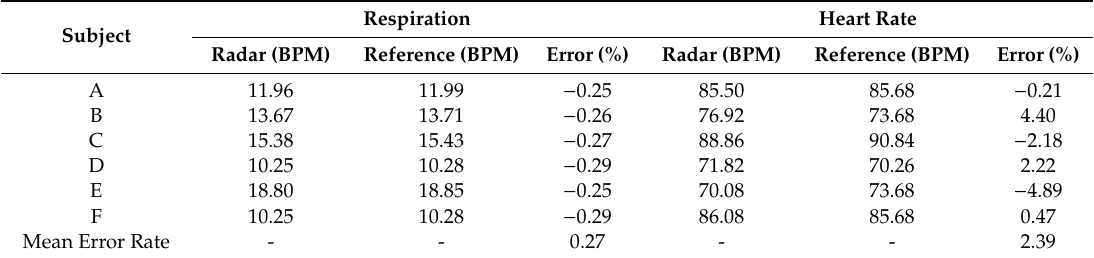
Table 6. Measured respiration and heart rates for six subjects by using the proposed radar sensor and the reference piezoelectric and ECG